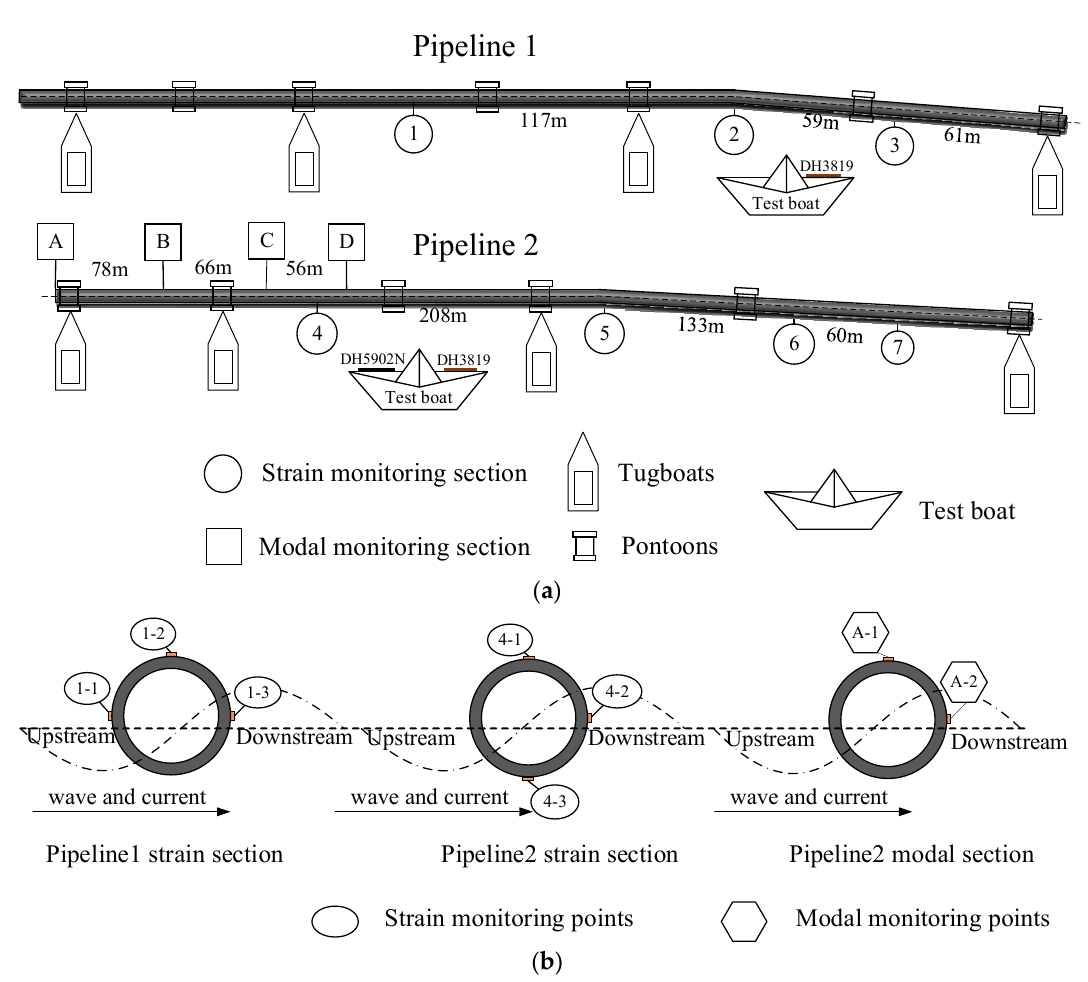
Figure 7. Arrangement of strain and modal measuring points. ( a ) Section arrangement of pipeline. ( b ) Point arrangement of section.